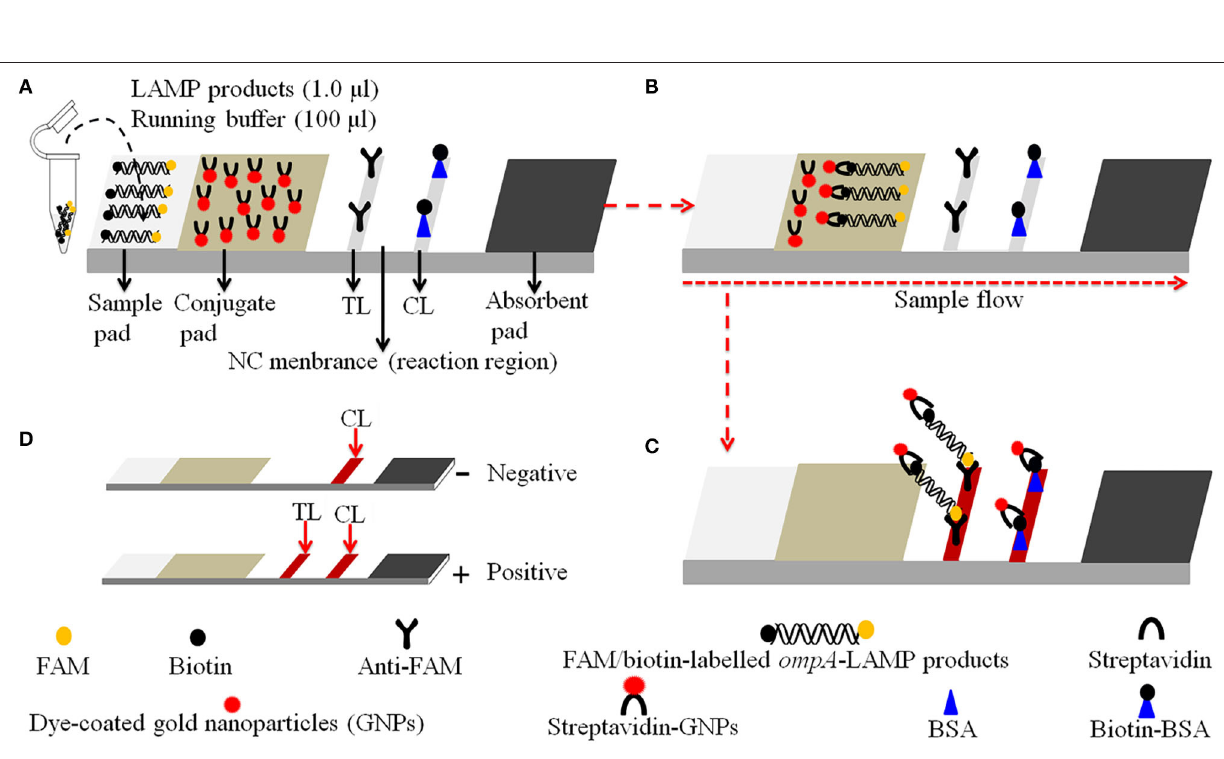
Frontiers in Microbiology | www.frontiersin.org